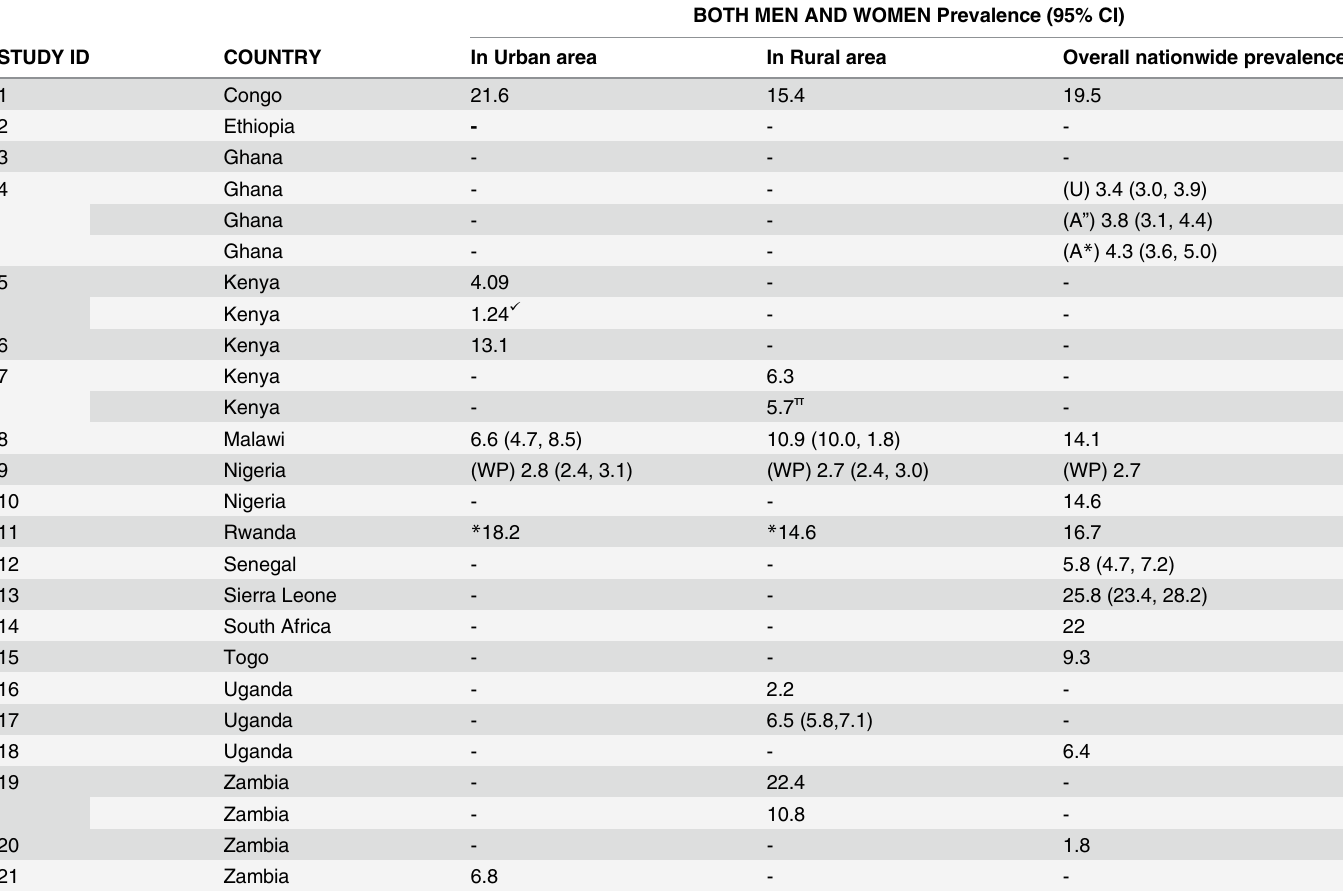
Table 2. Prevalence (95% CI) of current smoking among adults in sub-Saharan African countries by rural urban location or nationwide. BOTH MEN AND WOMEN Prevalence (95%